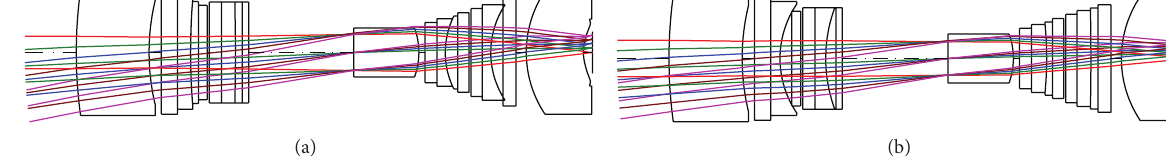
Figure 5: 1.4x zoom lens with liquid lens elements. (a) EFL = 5 mm and (b) EFL = 7